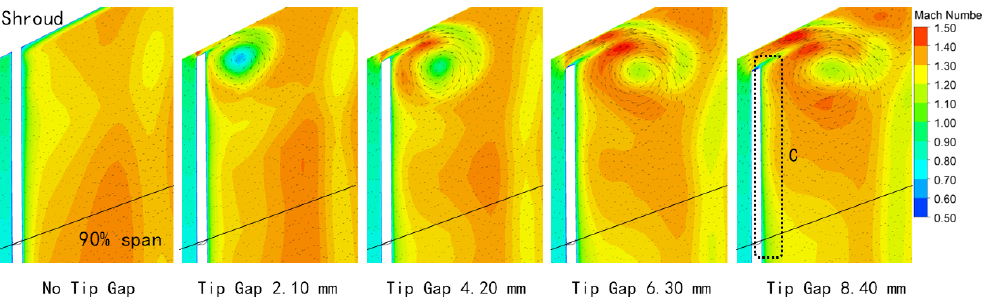
Figure 13. Mach number contour and the vector of velocity at 80% axial chord of the rotor. The suction side of the blade is located on the right